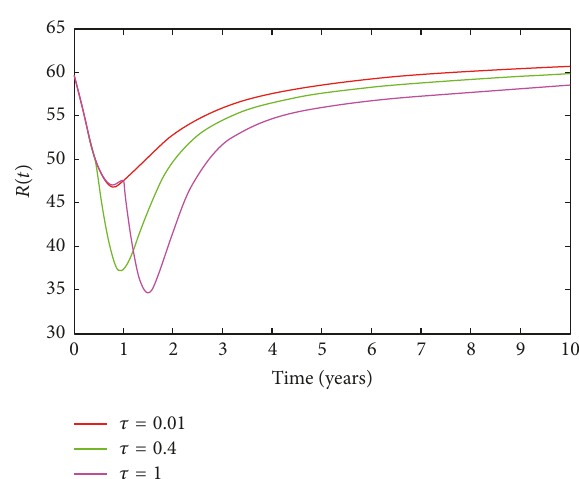
Figure 10: The approximate solution of 𝑅(𝑡) with different 𝜏 , using NSFDM, 𝛼 = 1